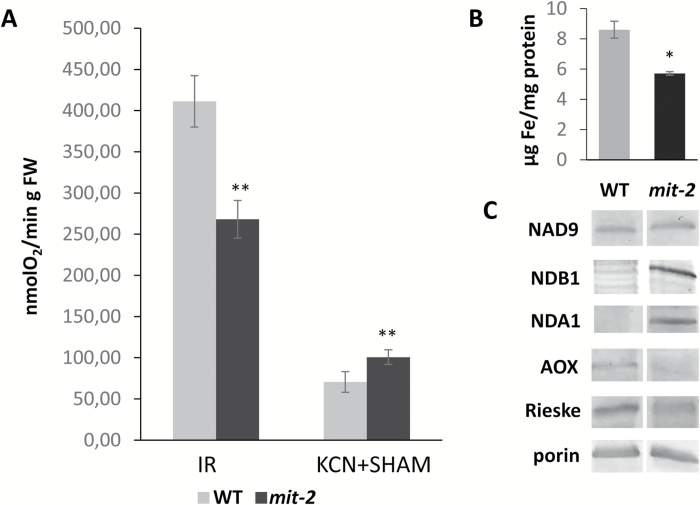
Biochemical characterization of purified mitochondria from roots of mit-2 and WT plants showed alterations in the respiratory chain in mit-2. (A) O2 consumption of root tips. The specific inhibitors of the respiratory chain (KCN for cytochrome c oxidase and SHAM for alternative oxidase) were added after recording the initial O2 consumption rate (IR). The difference between IR and the O2 consumption recorded after addition of KCN+SHAM provides the contribution of the mitochondrial O2 consumption rate. (B) Mitochondrial Fe concentration in roots. (C) Western blot analysis of mit-2 and WT roots. For each sample, 10 µg of protein was used. The antibodies used were for: NAD9 (a subunit of complex I), alternative NAD(P)H dehydrogenases (NDB1 and NDA1), AOX (alternative oxidase), Rieske (a subunit of complex III), and porin (used as loading control). Error bars represent the SD. Column bars followed by an asterisk are significantly different from the WT according to Student’s t-test (n=3, *P<0.01; **P<0.001).